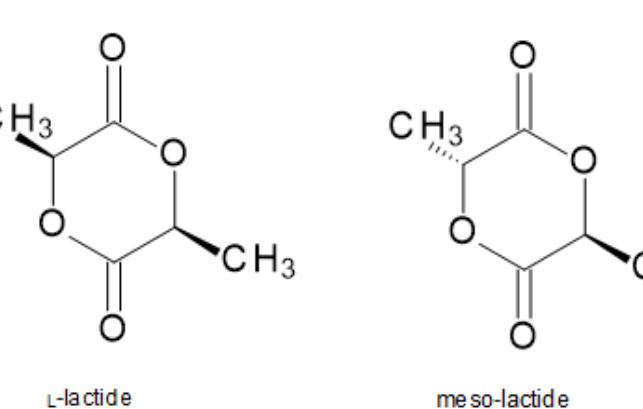
Figure 7. Flow diagram of the azeotropic dehydrative polycondensation of LA [28].